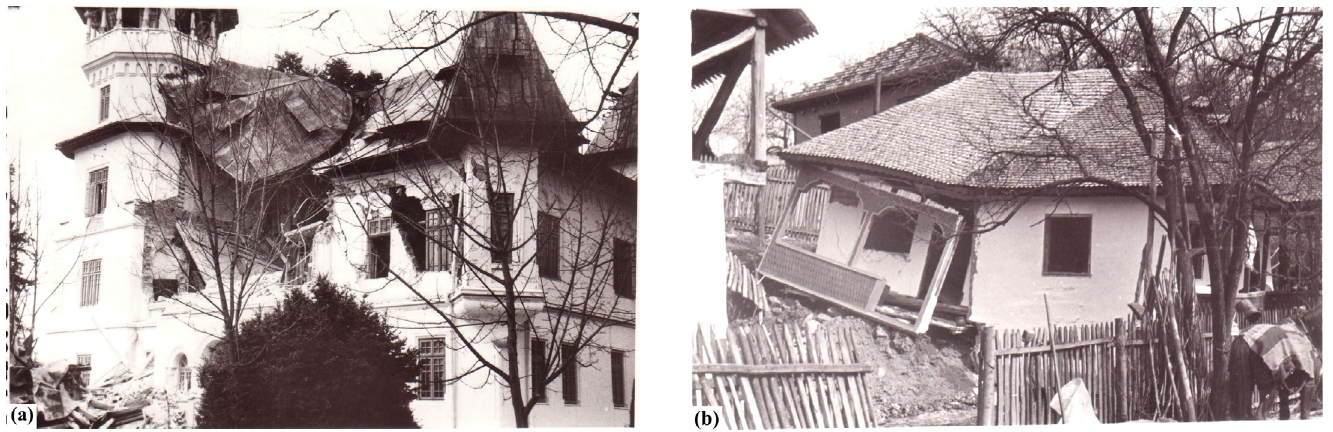
Figure 5. Partial collapse of a masonry building at Drajna (a) and heavy damage to a wooden house at Slon (b), in Prahova county (photos by Pantea